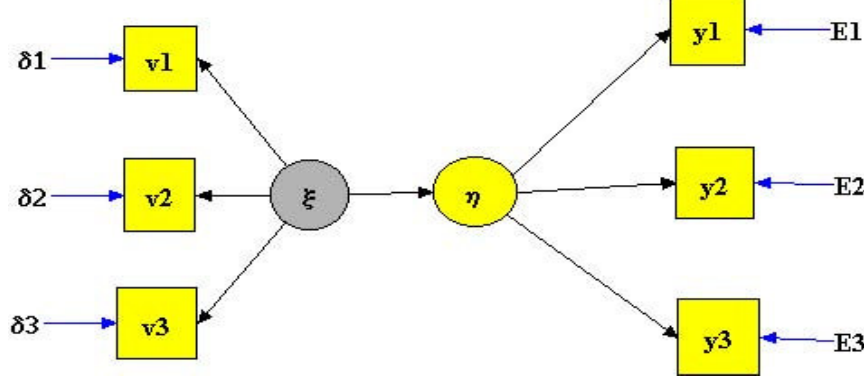
Figura 1 – Path diagram di LISREL e PLS , con ηηηη e ξξξξ